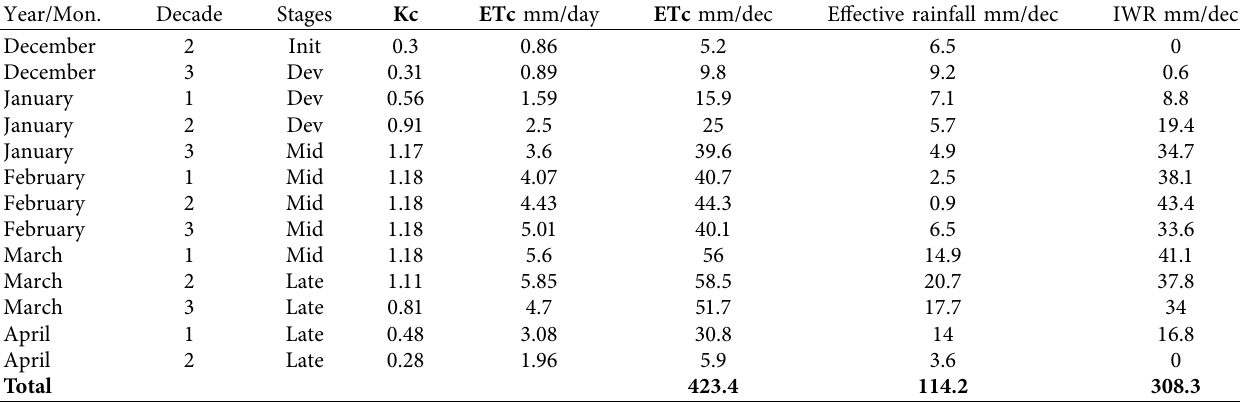
Table 6: CWR of barley at different